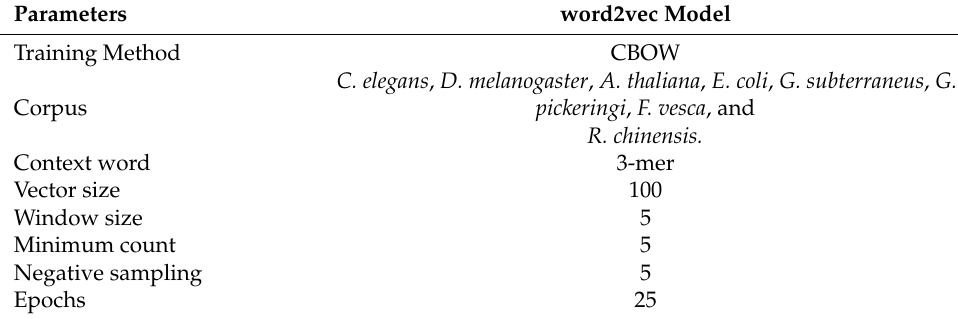
Table 3. Training parameters used in